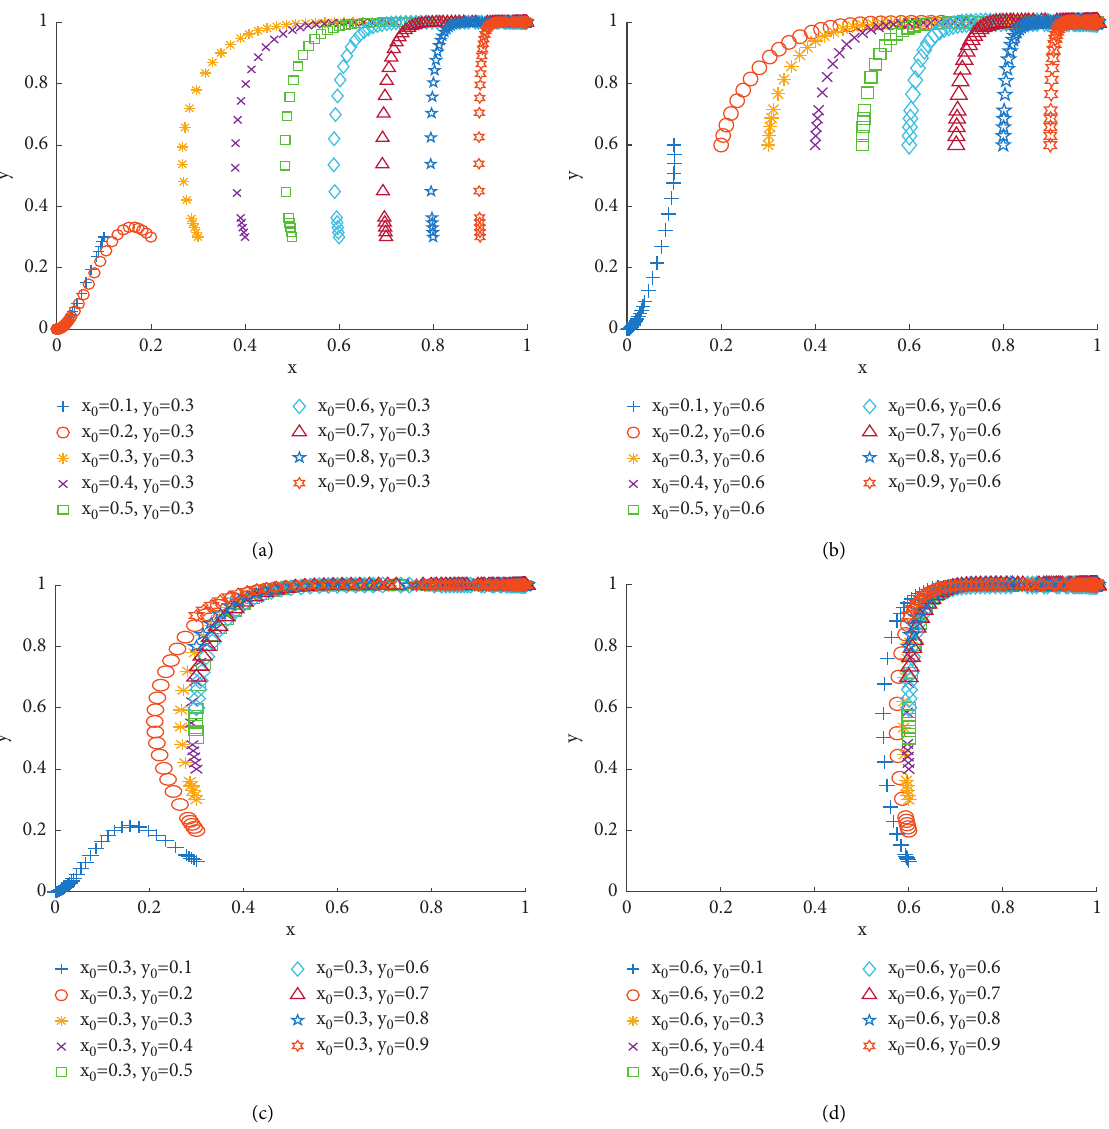
� 0.3, (b) y � 0.6, (c) x � 0.3, and (d) x 0 0 0